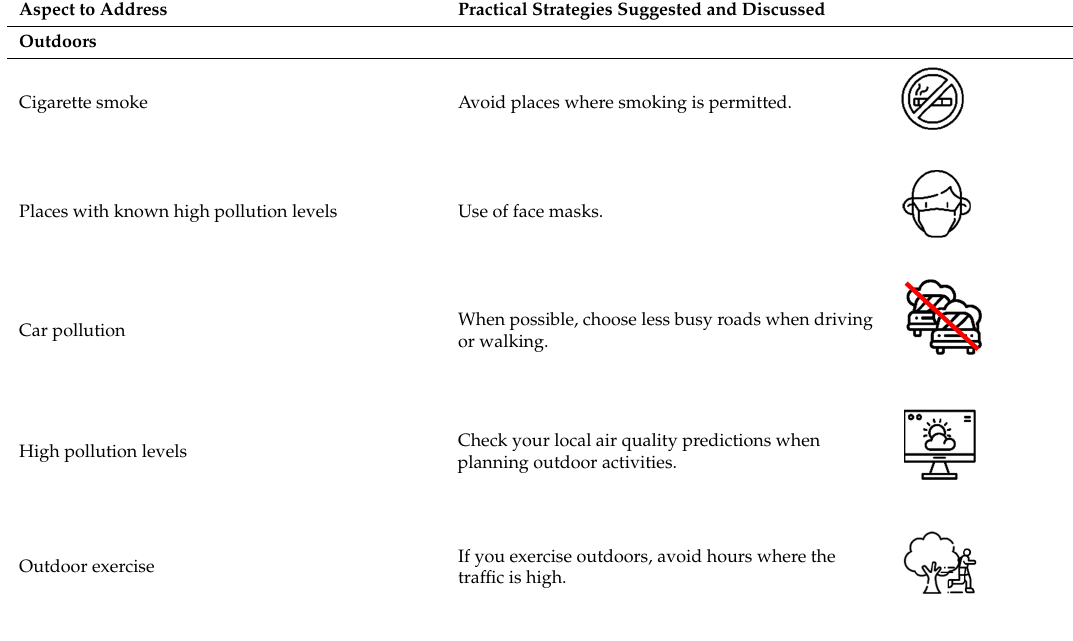
Table 2. Description of the education session on the environment, delivered in the community-based pulmonary rehabilitation program to people living with chronic obstructive pulmonary disease.